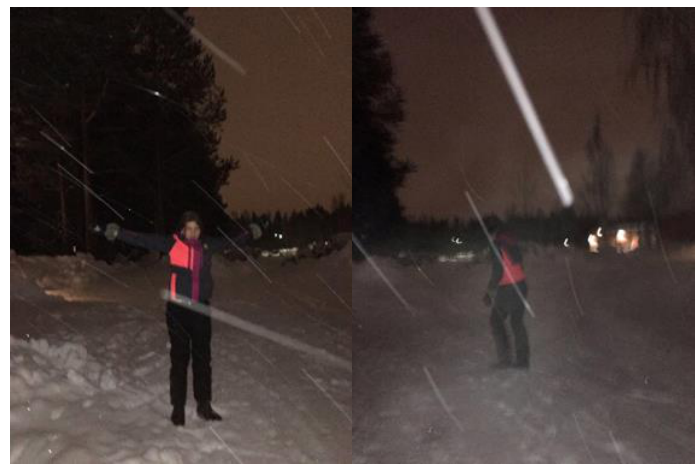
Figure 4. “It is early in the morning and really cold outside, snowy and windy. Despite this I do not hesitate to walk to school, I get fresh air, and it is actually nice when I have accomplished it” Ida C12.